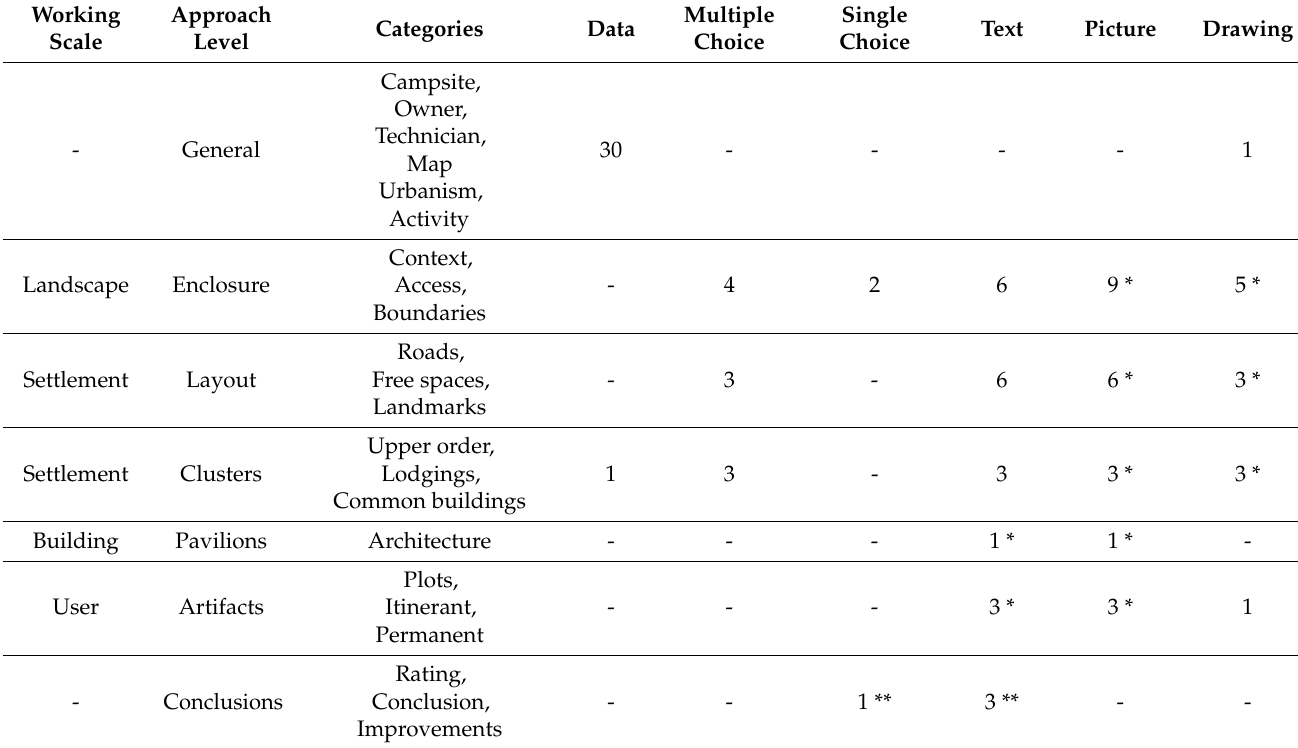
Table 4. Structure of the diagnosis sheet by approach levels and categories. Numbers indicate the amount of elements recorded in each section according to content typology (Source: authors’